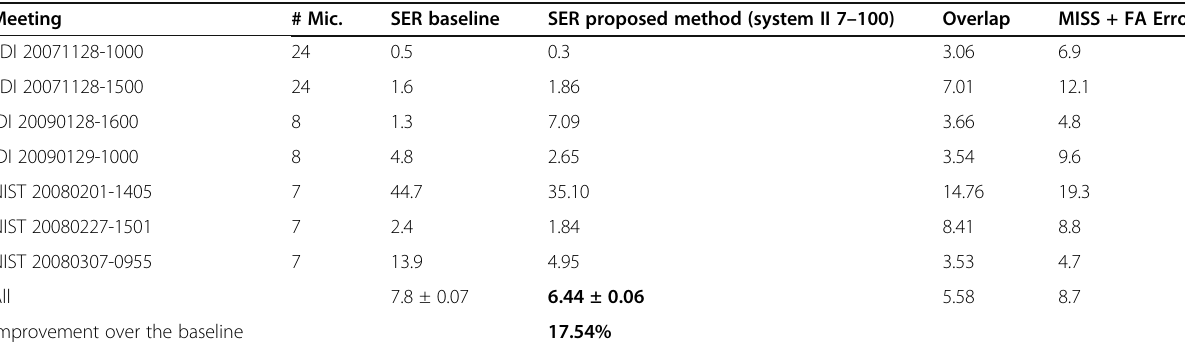
Table 5 Detailed % SER results comparing baseline systems and the improvements for rt09. The last two columns show the overlap speech/non-speech errors common to both of them Meeting # Mic. SER